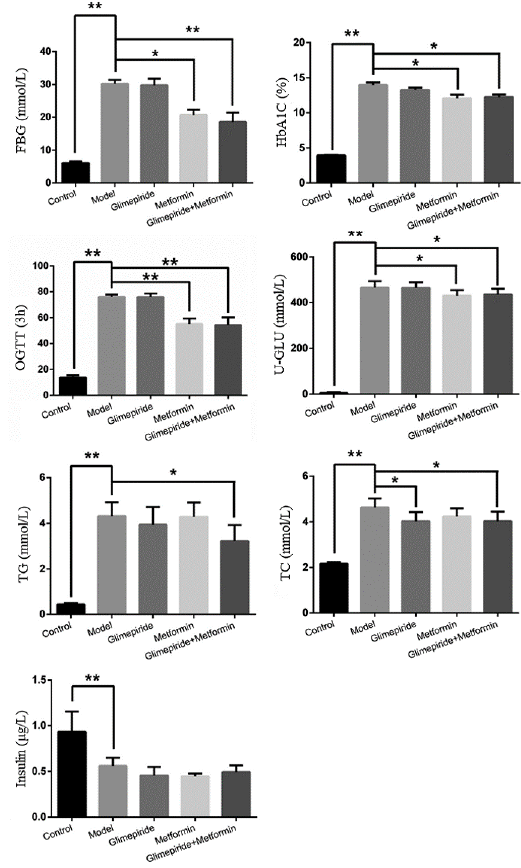
Figure 1. The levels of fasting plasma glucose (FBG), glycosylated hemoglobin (HbA 1c ), oral glucose tolerance (OGTT), urinary glucose (U-GLU), triglyceride (TG), total cholesterol (TC), and insulin of the control group, model group, and groups treated with glimepiride, metformin, and their combination. The values are shown as mean ± SD for six animals. * p < 0.05 versus values for the model group, ** p < 0.01 versus values for the model group.